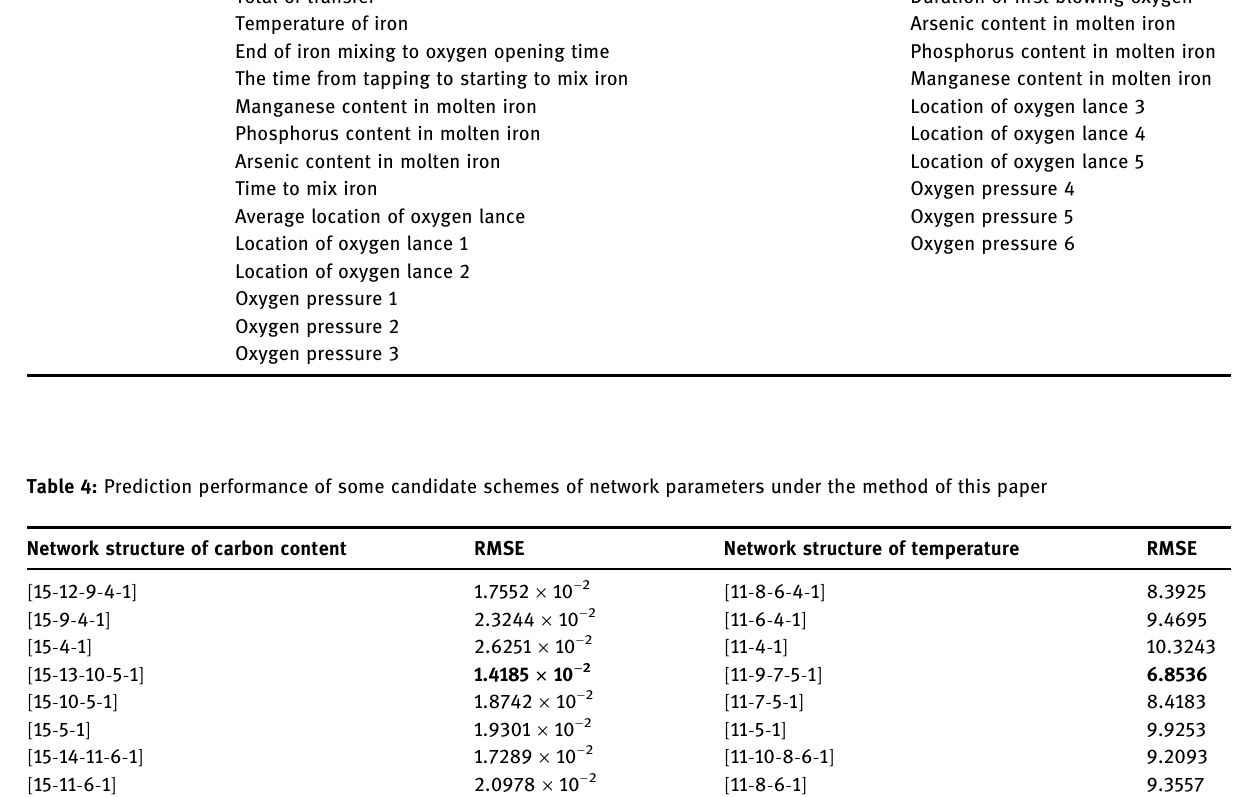
Bold represent the relative optimal value under this indicator in the comparison